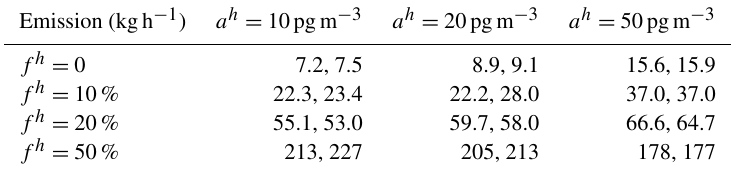
o ) ] 2 +[ ln ( 1 + f h + a h ) ] 2 . f o = 20%, c o m c h m